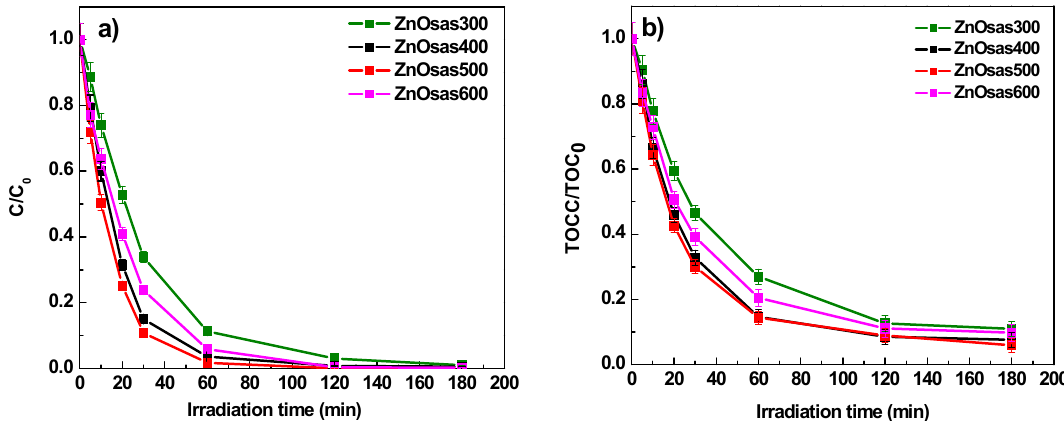
Figure 8. ( a ) Photocatalytic decolorization of crystal violet (CV) and ( b ) Total Organic Carbon (TOC) behavior under UV light using zinc oxide (ZnO) from supercritical antisolvent (SAS) zinc acetate (ZnAc) nanoparticles calcined at 300, 400, 500, and 600 °C.